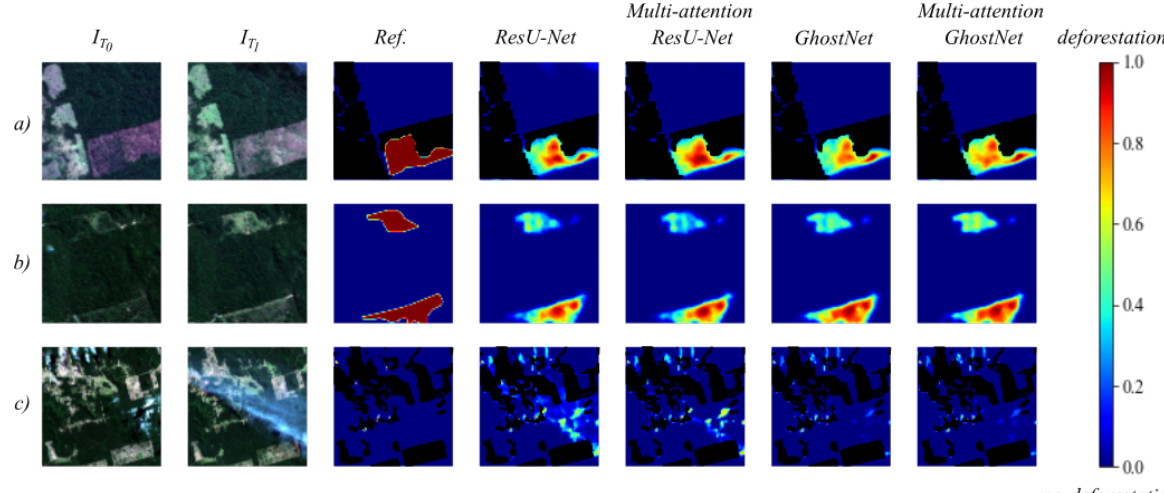
Figure 5. Deforestation probability maps of three different snips from the test tiles. From left to right: input snip of the 2018 image; input snip of the 2019 image; reference; probability maps (ResU-Net, Multi-attention ResU-Net, GhostNet, Multi-attention GhostNet). Blue and red colors represent lower and higher probability of belonging to the deforestation class, respectively. Black regions correspond to past-deforestation